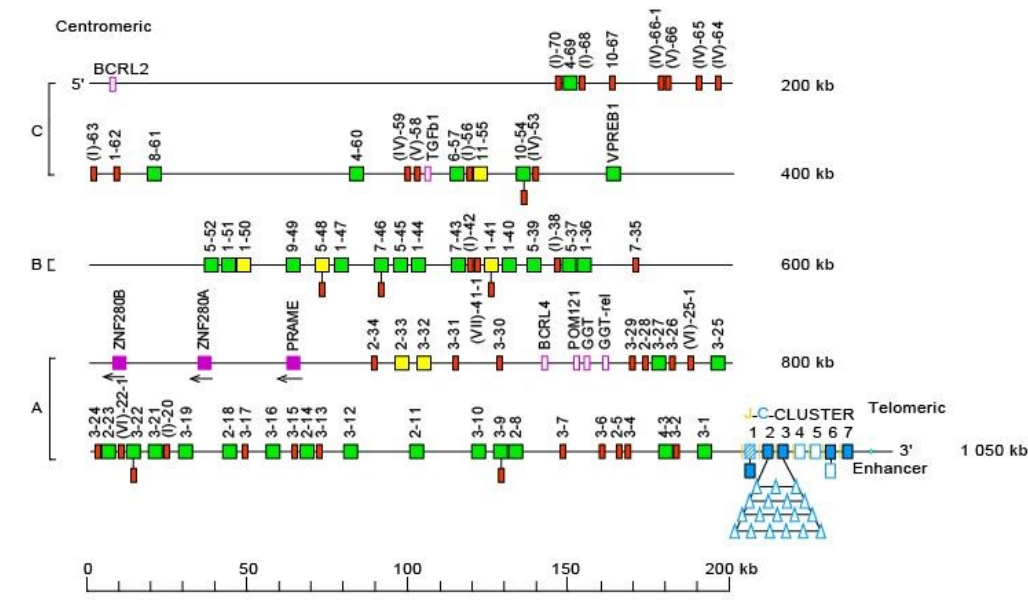
Figure 19. Representation of the human IGL locus at 22q11.2 [2]. The boxes representing the genes are not to scale. Exons are not shown. ( A – C ) refer to three distinct V-CLUSTER based on the IGLV gene subgroup content [271]. Pseudogenes which could not be assigned to subgroups with functional genes are designated by a Roman numeral between parentheses, corresponding to the clans, followed by a hyphen, and a number for the localization from 3 ′ to 5 ′ in the locus. (With permission from M ‐ P. information system ® , http://www.imgt.org).